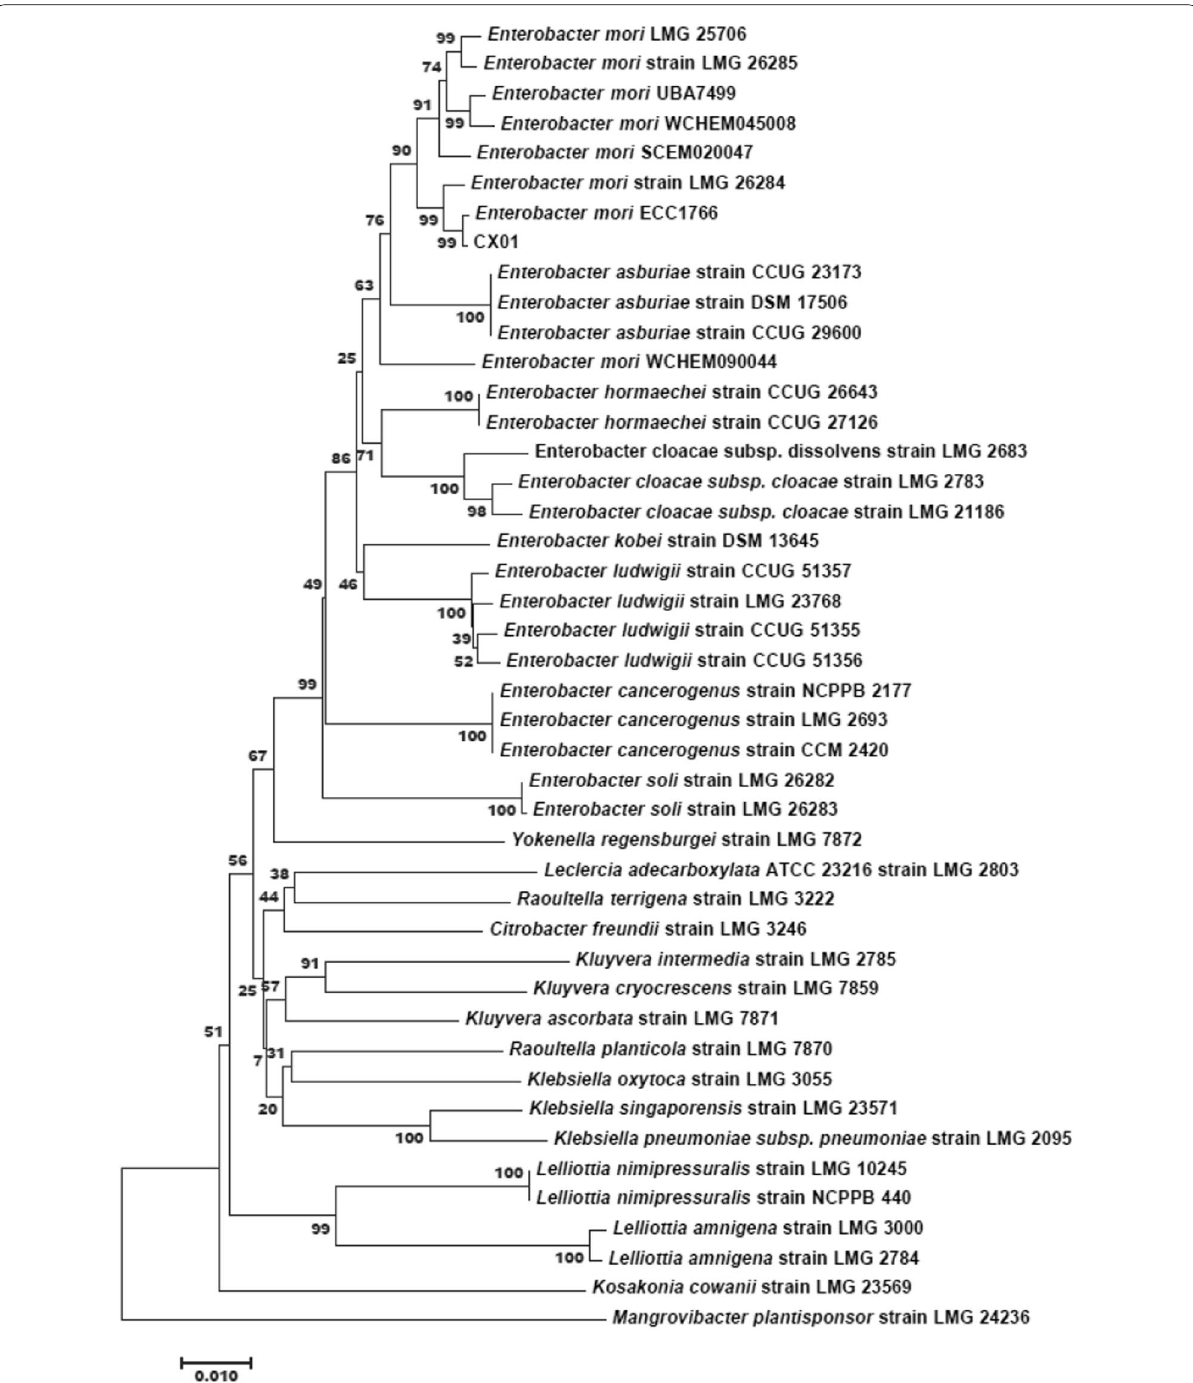
Fig. 2 Phylogenomic analysis of Enterobacter and other genus bacteria. Phylogenetic tree reconstructed from multilocus sequence analysis (MLSA) based on four housekeeping genes gyrB - rpoB - atpD - infB , showing the relationships between E . mori CX01 and the related type strains. The phylogenetic tree was inferred by the neighbor-joining method with the software MEGA7 (Kumar et al. 2016). The bar indicates a 0.01% nucleotide substitution